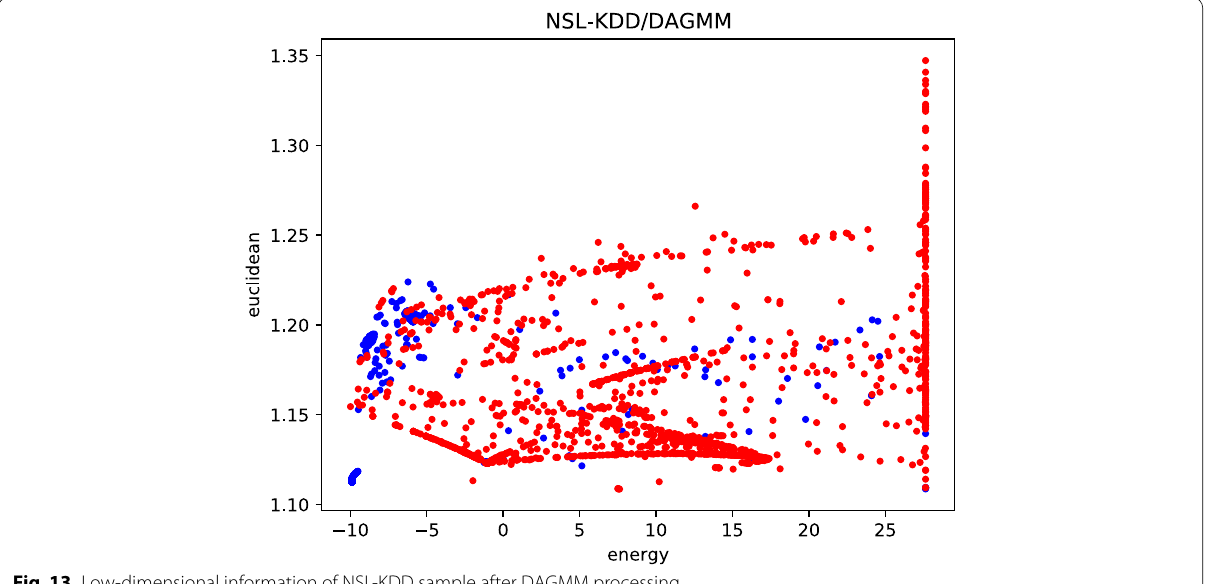
Fig. 13 Low-dimensional information of NSL-KDD sample after DAGMM processing